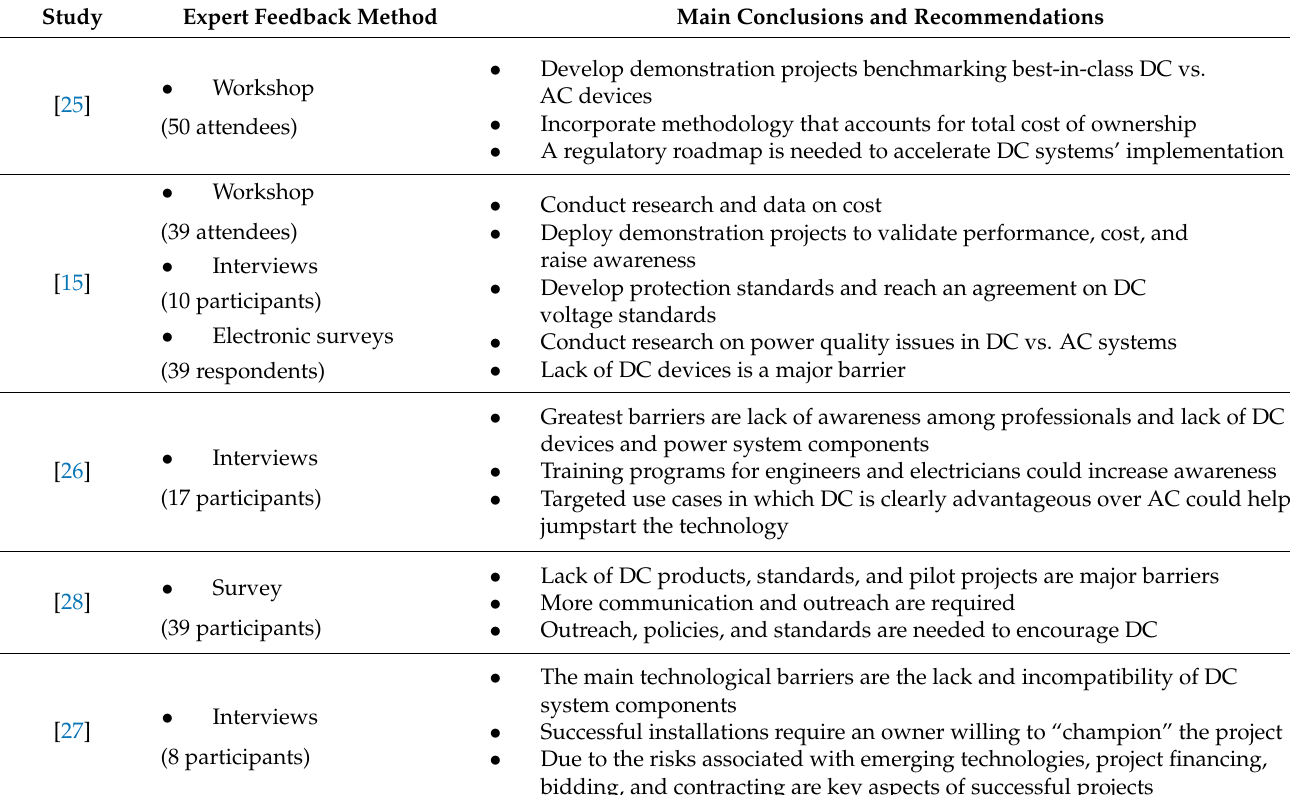
Table 1. Summary of expert feedback on DC distribution